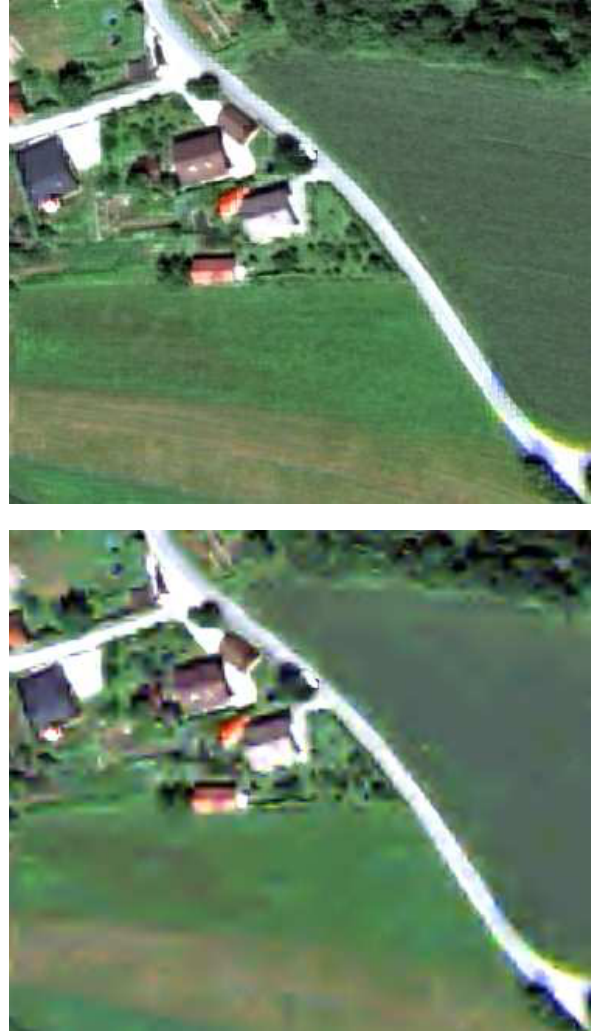
Figure 1. An excerpt from the original image (top) and the compressed image at 100:1 ratio (bottom).